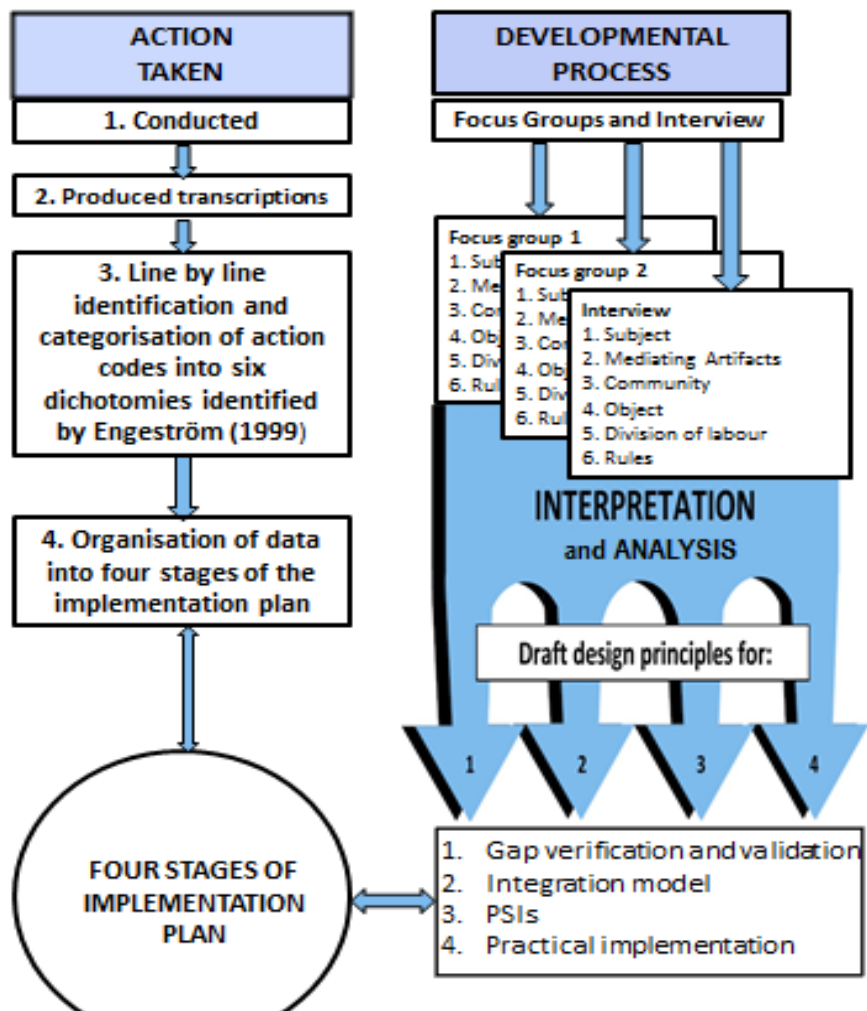
FIGURE 2: Data collection and analysis: substantiation cycle Source: Author’s